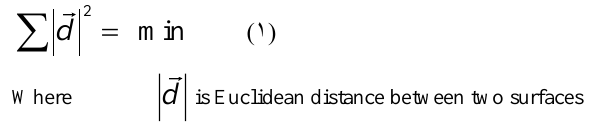
Figure 3.The output of the pixel-based fuzzy classification (top- right), result after neighbourhood analysis (top-left), Bottom: The final output of